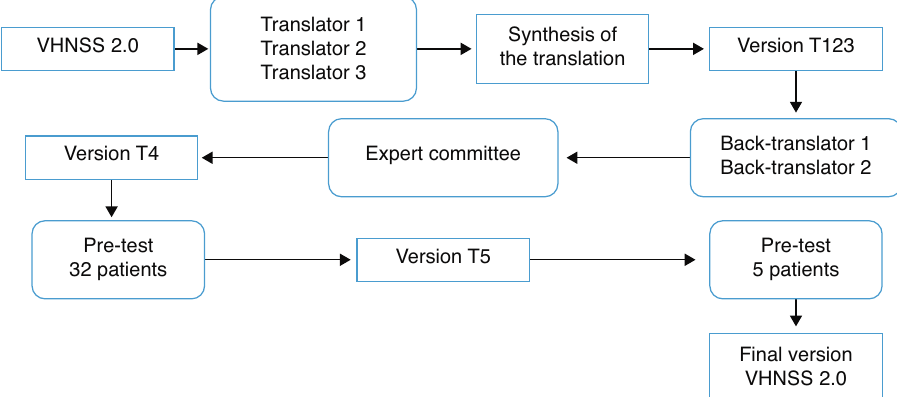
Methodological steps used in the translation and cross-cultural adaptation of the Vanderbilt Head and Neck Symptom Survey (VHNSS) version